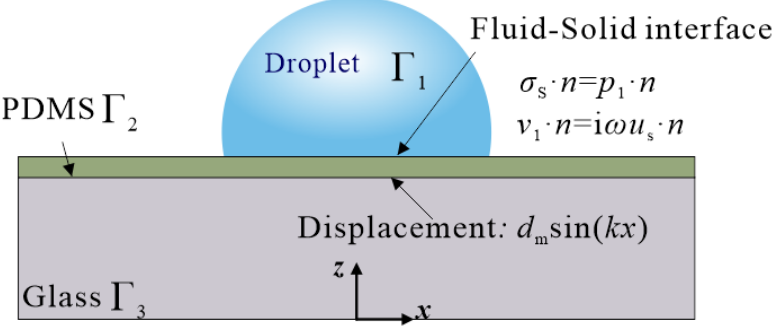
Figure 2. The numerical model details. In the FE model, Γ 1 is the droplet area, Γ 2 is the PDMS area, and Γ 3 is the glass area.